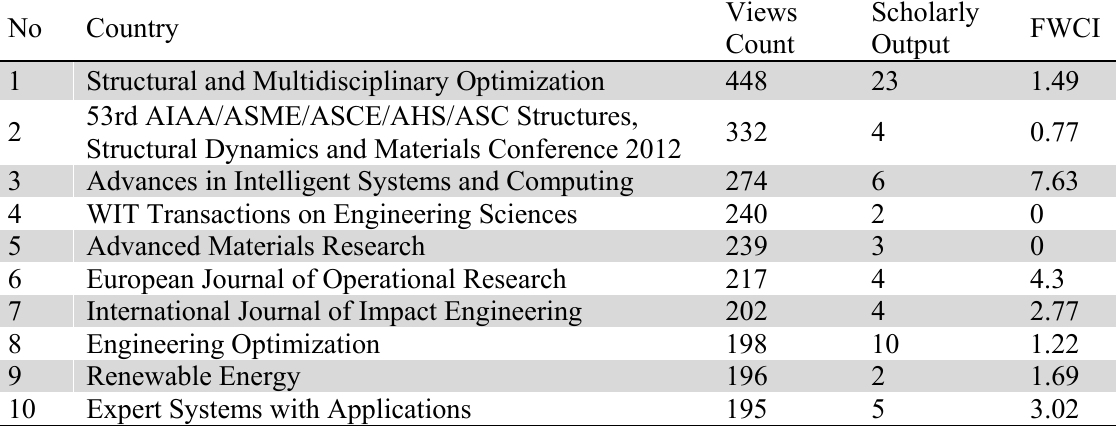
Top ten high view counts journals in field